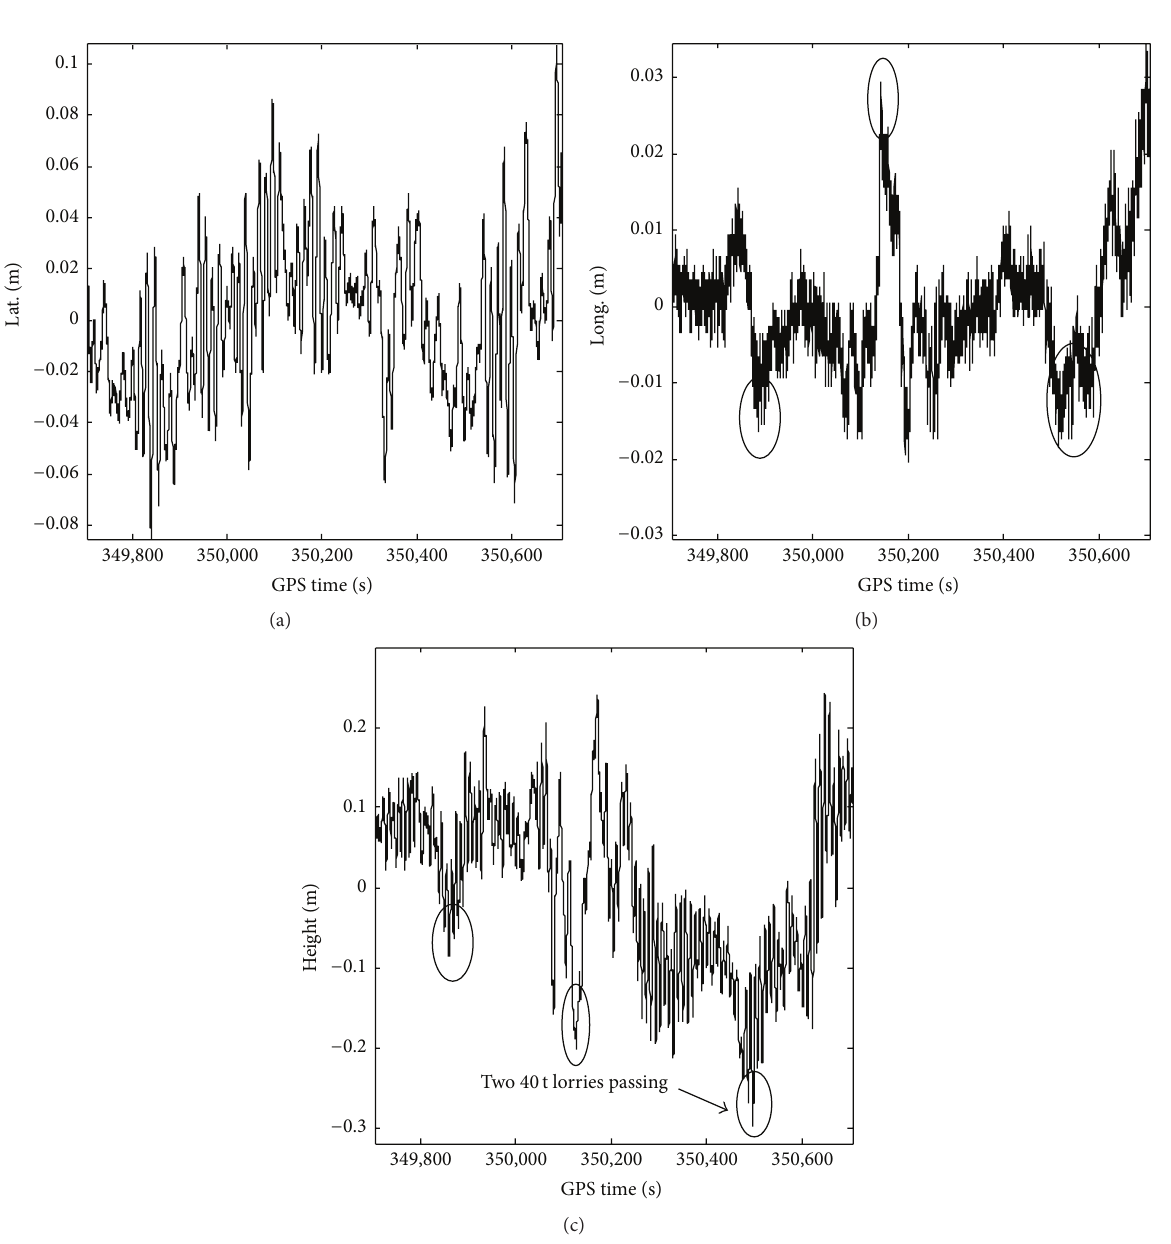
Table 2: Vibration frequencies extracted from longitudinal GPS measurements ( 𝑌 direction of BCS). Extracted frequencies (Hz) Mean wind speed Situations (km/h)Common frequencies Distinct frequencies Ambient circulation loading Strong wind (abrupt wind speed change) Two 40 t lorries